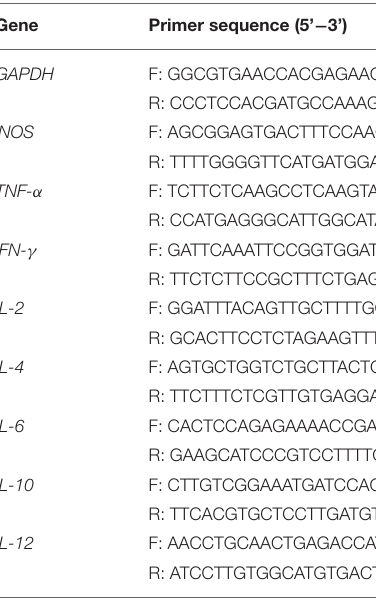
TABLE 3 | Primer sequences for SYBR green real-time quantitative